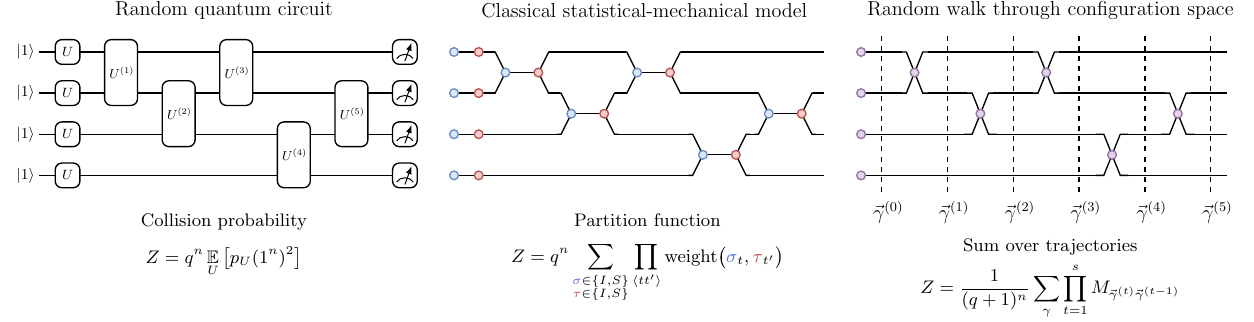
FIG. 4. A diagram depicting the equivalent ways to interpret the expected value of the collision probability for RQCs. Left: a RQC of size five. Middle: the reinterpretation as the partition function of a classical statistical-mechanical model with local Ising-like spins. Right: another interpretation as a stochastic process of evolving